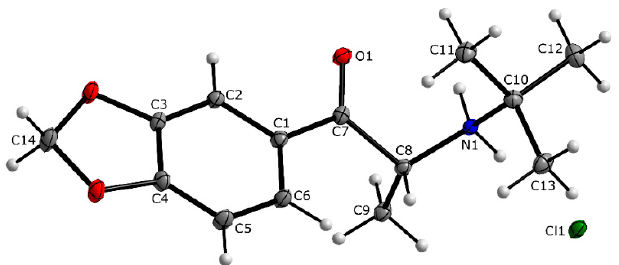
Figure 5. The molecular structure of 1-(1,3-benzodioxol-5-yl)-2-(tert-butylamino)propan-1-one